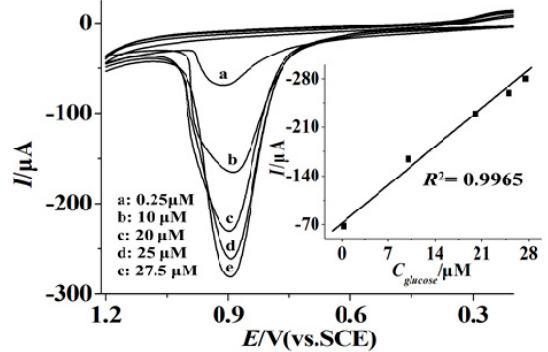
Figure 4. CVs of glucose oxidase (GOx)-induced formation of gold nanoparticles (AuNPs) for increasing concentrations of glucose. Glucose concentration ranges: ( a ) 0.25 μ M; ( b ) 10 μ M; ( c ) 20 μ M; ( d ) 25 μ M and ( e ) 27.5 μ M. Inset: plot of peak current vs. glucose concentration. Reaction solution: a stirred 0.1 M phosphate buffered saline (PBS) solution containing 0.2 mM HAuCl 4 and different concentrations of glucose.